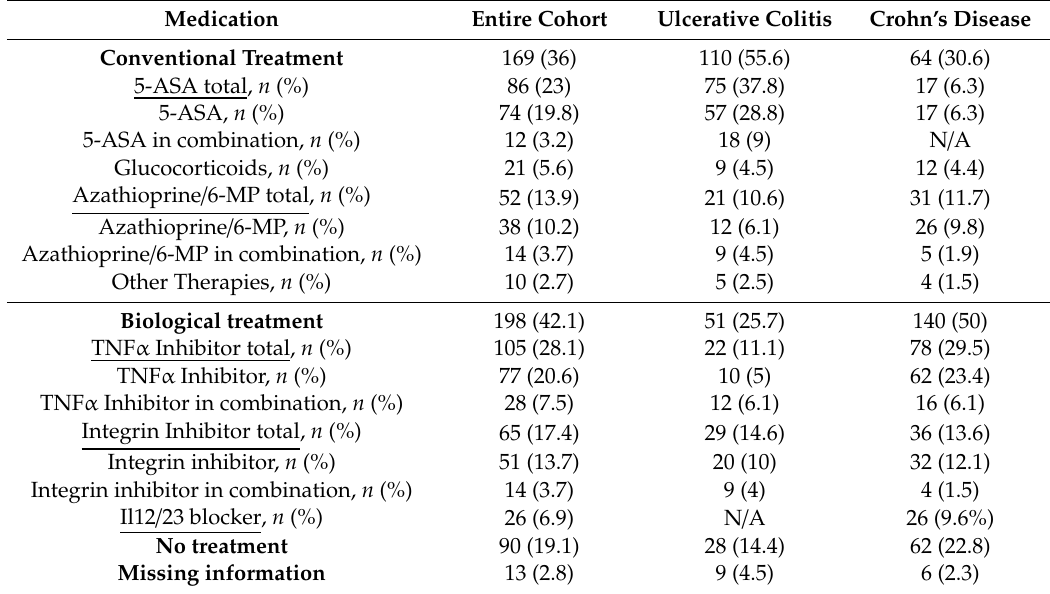
Table 3. Inflammatory Bowel Disease (IBD)-related Medication.